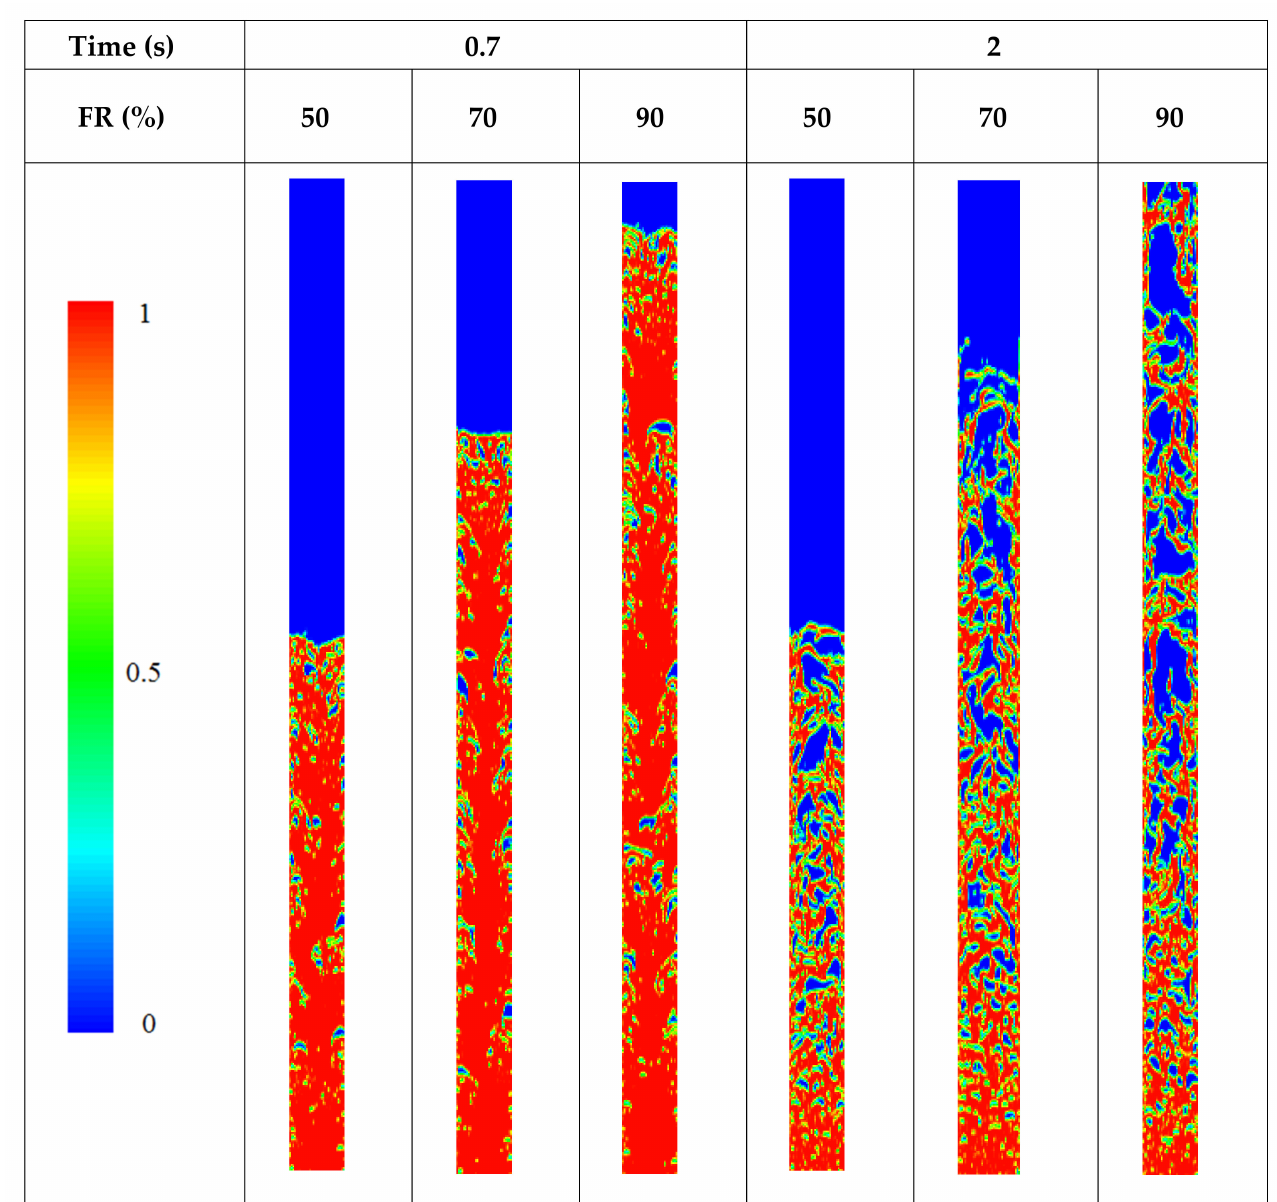
Figure 8. Comparison of liquid volume fraction contours in evaporator for different filling ratios at two different